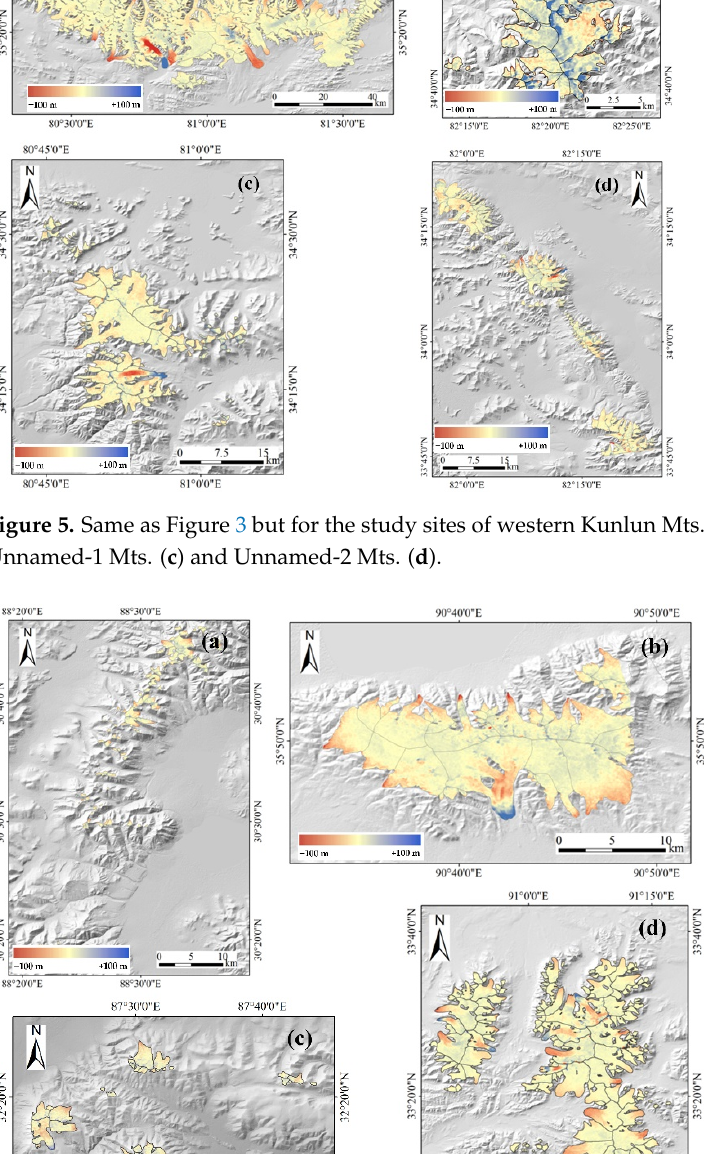
Figure 6. Same as Figure 3 but for the study sites of Unnamed-7 Mts. ( a ), Malan Mount ( b ), Unnamed-6 Mts. ( c ) and Geladandong Mts. ( d ).